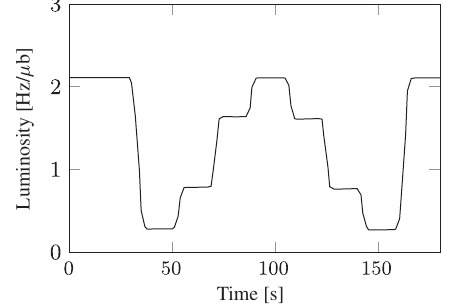
FIG. 2. Luminosity evolution during a scan in one plane.